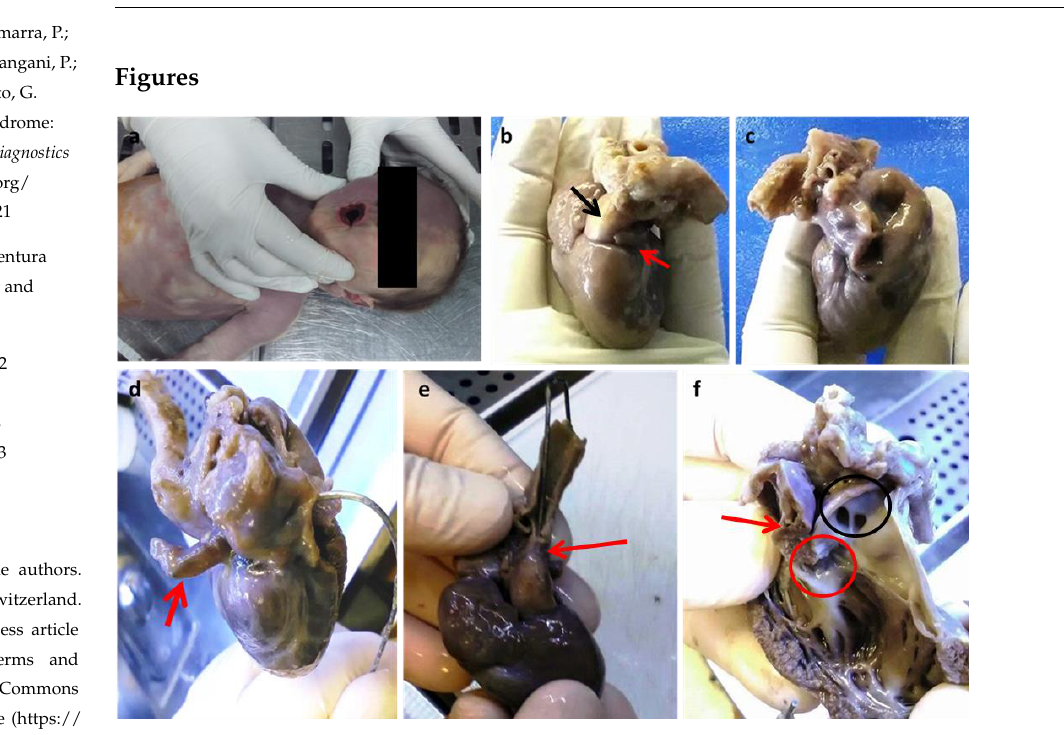
Figure 1. ( a ) Cyanosis of the buccal rim. Anterior face ( b ) and posterior face ( c ) of the heart. The red arrow points to a small and virtual auricle-like left atrial cavity ( b ) which is better highlighted by the introduction of a probe ( d ); the black arrow indicates the emergence cone of the predominant pulmonary trunk which is predominant ( b ). Evidence of hypoplastic aorta after rotation of the heart towards the posterior face ( e ). Prevalence of the right ventricle ( f ): the red arrow indicates a small residual left ventricular cavity with a small residual sept; the red circle is the only identified right valve; the black circle indicates the emergence of the right and left pulmonary vessels above the emergence of the common trunk. Dissection of the right anterior ventricular wall and pulmonary trunk following the outflow route. (Images from Mansueto's forensic archive). The missing intrau- terin diagnosis of fetal defects could be the cause of unexpected newborn deaths. HLHS is a syn- drome characterized by multiple congenital cardiac structural abnormalities, which was first de- scribed by Lev in 1952 [1]. Currently, the mortality rate from HLHS is approximately 2 – 3% of all congenital heart diseases, with 23% of deaths within the first week and 15% within the first month [1,2]. Treatment has enabled infants with HLHS to survive beyond the first decade of life, with a reported 15-year survival of 48% and significant mortality during the first year of life [2 – 4]. An al- teration of cardiogenesis is now clearly identified as the cause of the underdevelopment of the left heart, which is associated in most cases with mitral and ascending aortic anomalies in HLHS. Con- sistent with multifactorial aetiology and impaired cardiogenesis, HLHS, therefore, represents a syn- drome in which the phenotypic spectrum can vary and be more or less faithful to the identified entities. In addition to defective cardiogenesis, left ventricular hypoplasia can also be explained by decreased blood flow during development. Both of these factors can coexist [5,6]. During intrauter- ine life, the vascular system of the fetus reaches a functional balance supported by maternal-fetal circulation. The maternal-fetal balance is lost after birth, after the ductus arteriosus and foramen ovale close, resulting in rapid cardiorespiratory failure. Therefore, the early diagnosis of HLHS is essential for timely medical therapy and for the choice of surgical therapy consisting of heart trans- plantation and/or palliative procedures. We describe a case of HLHS-diagnosed post-mortem. A female newborn at 38 weeks of gestational age (birth weight of 2680 g; an Apgar score of 8/10/10) from a 37-year-old mother (multipara without risk factors or pathologies in the anamnesis) showed respiratory failure twenty-six hours after birth. Due to poor clinical condition (oxygen saturation